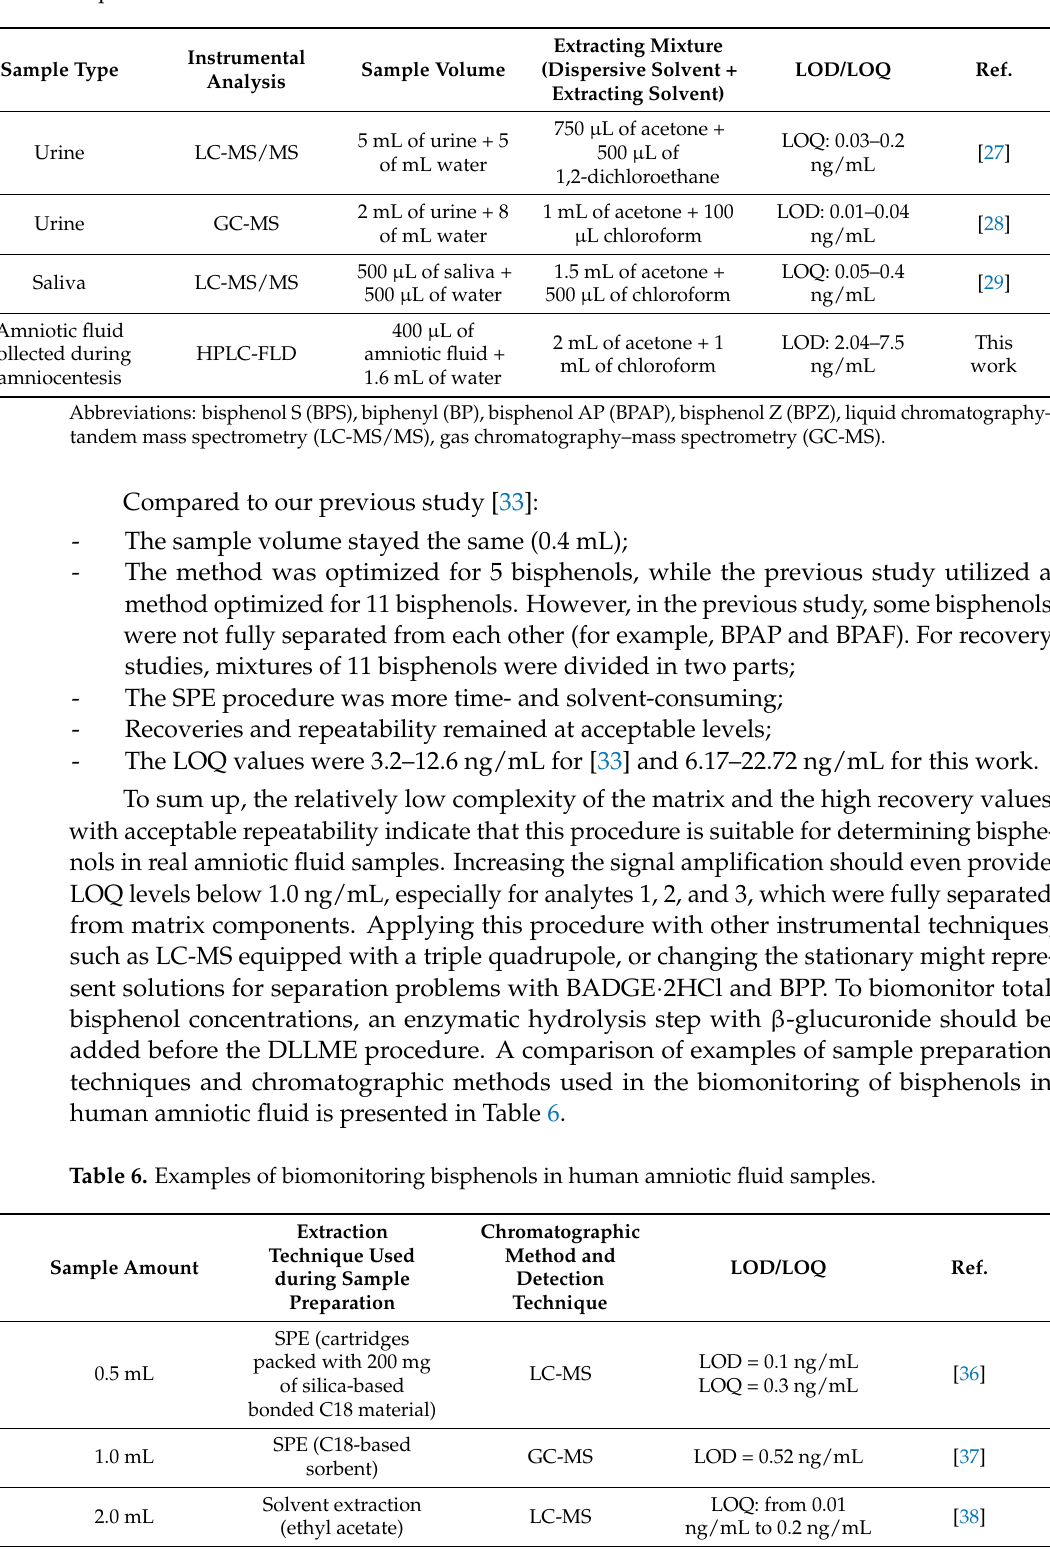
Table 5. Comparison of examples of previously published DLLME procedures for biomonitoring of bisphenols with the method described in this work.